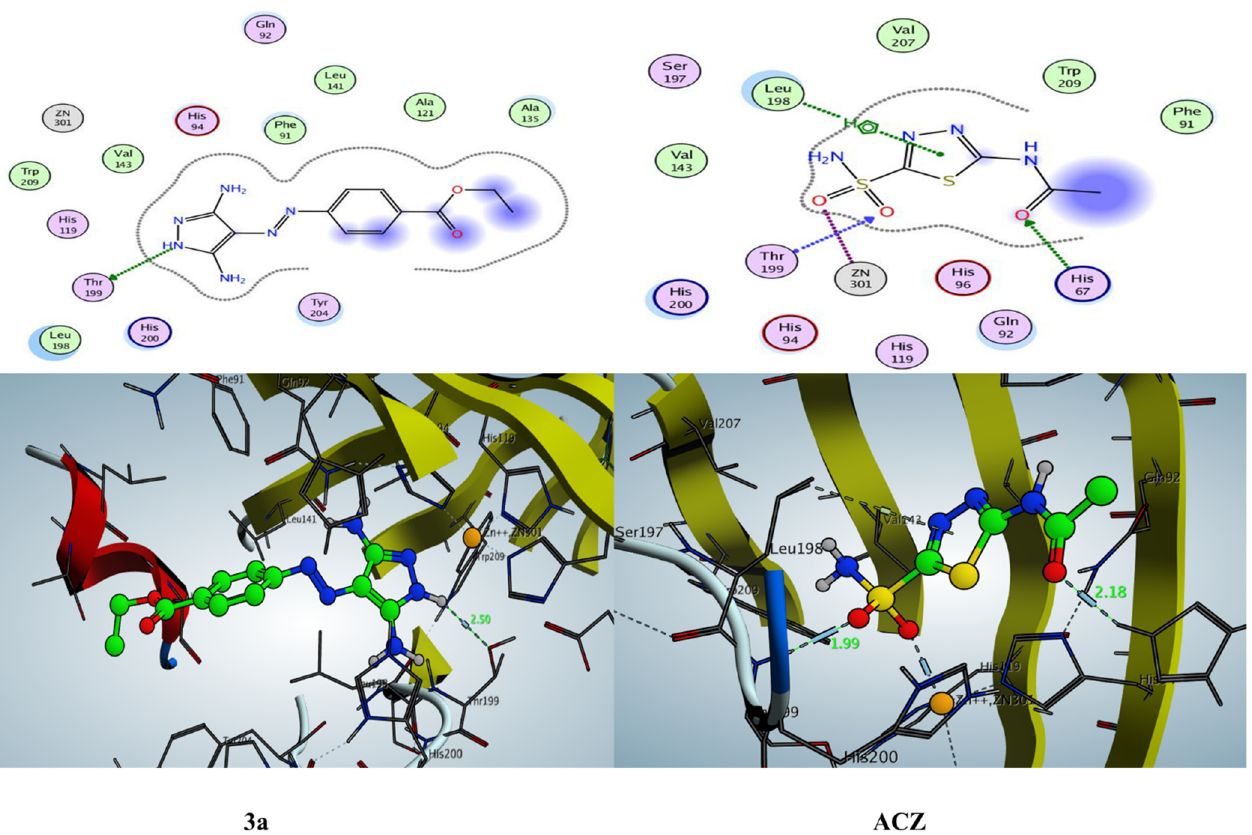
Figure 8. 2D and 3D enzyme–ligand interaction of compounds 3a and ACZ inside the active site of h CA-I.